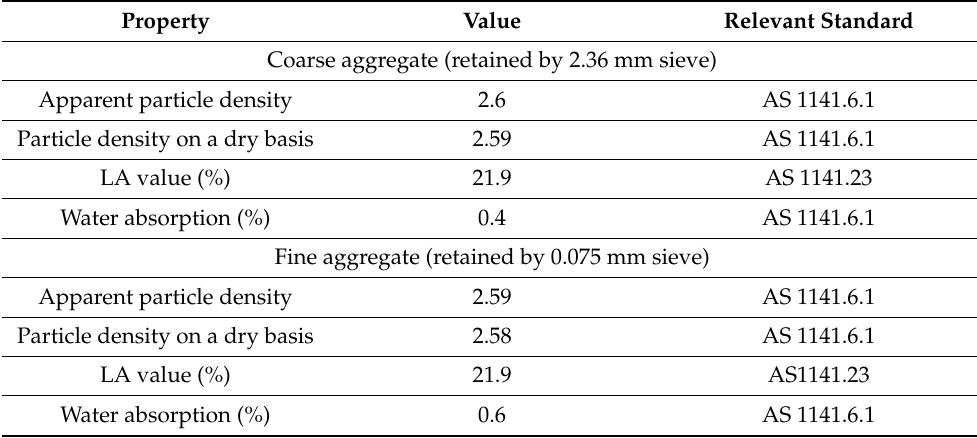
Table 4. Aggregate